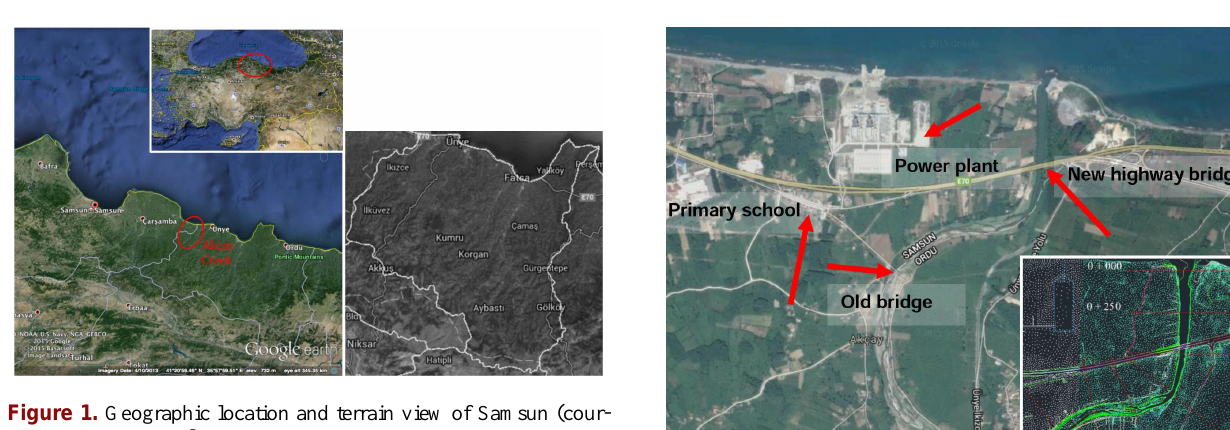
Figure 1. Geographic location and terrain view of Samsun (cour- tesy of GoogleEarth ® ) and Ikizce watershed.